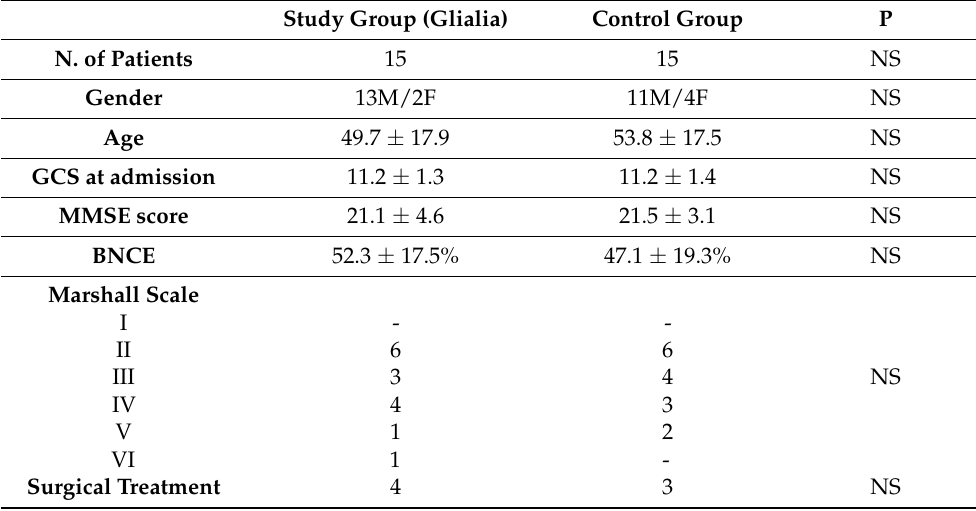
Table 2. Summary of demographic and clinical characteristics of patients at hospital admission.